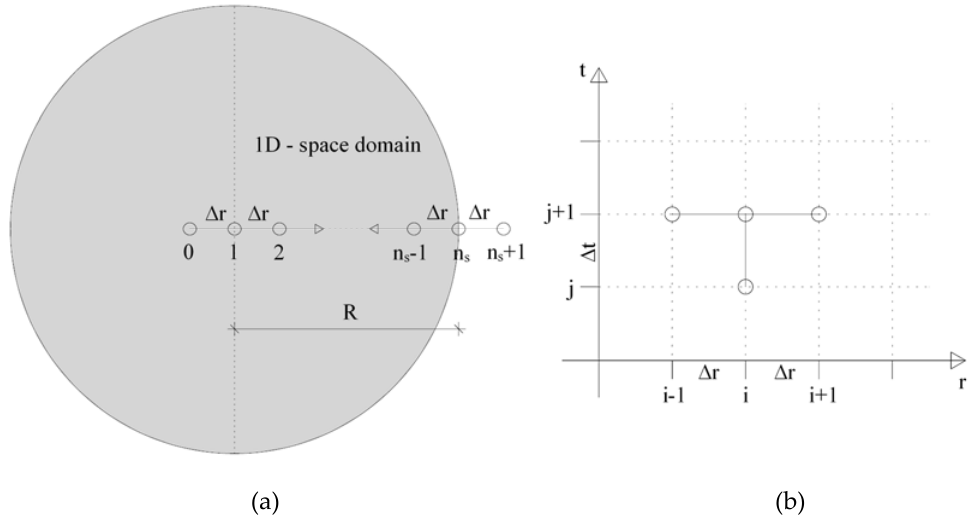
Figure 4. ( a ) Finite difference (FD) space discretization scheme of a 1D ‐ heat transfer in spherical specimens; ( b ) FD molecule for implicit time using the Backward Euler Method and the Space Central Method.